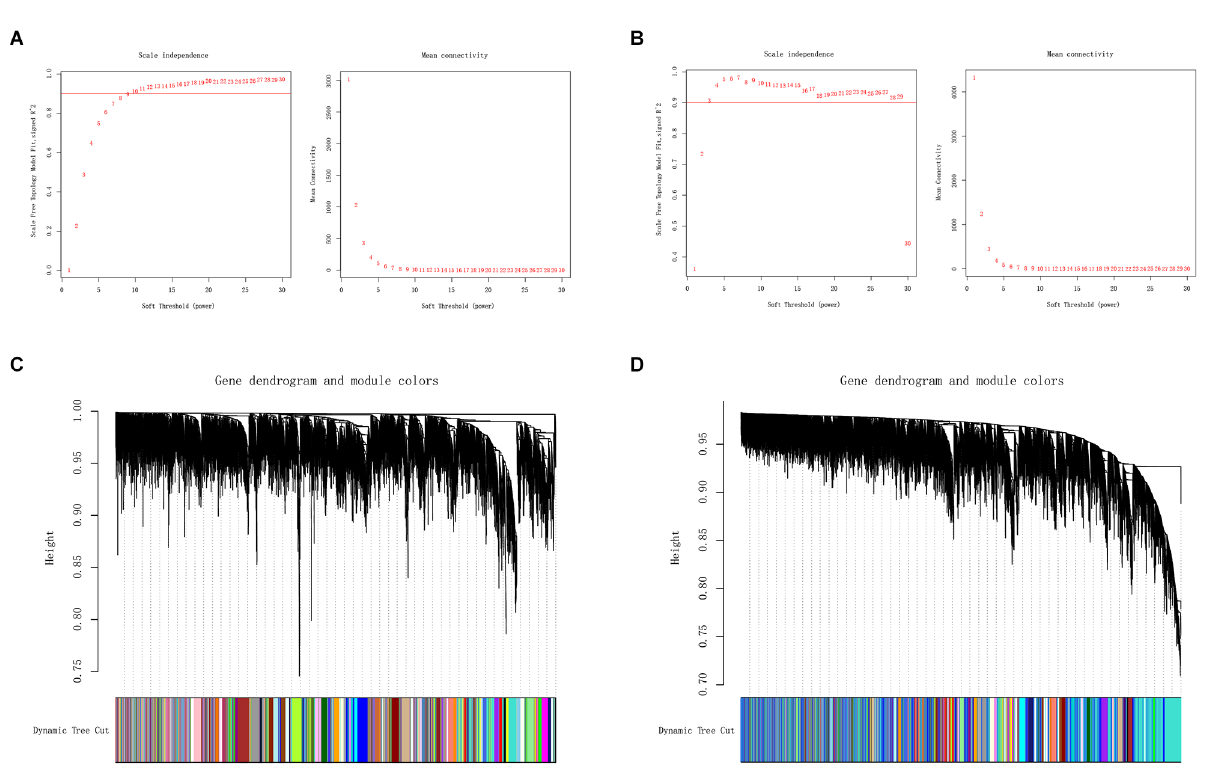
FIGURE3 (A,B) Definition of soft threshold power through Weighted Gene Co-Expression Network Analysis (WGCNA). Scale-free indices and mean connectivity were analyzed for various soft threshold powers ( β ). (C,D) A gene dendrogram was created by averaging the results of a chain hierarchy clustering algorithm. The colorful rows underneath the tree diagram indicated the assignment of modules based on dynamic tree cutting.